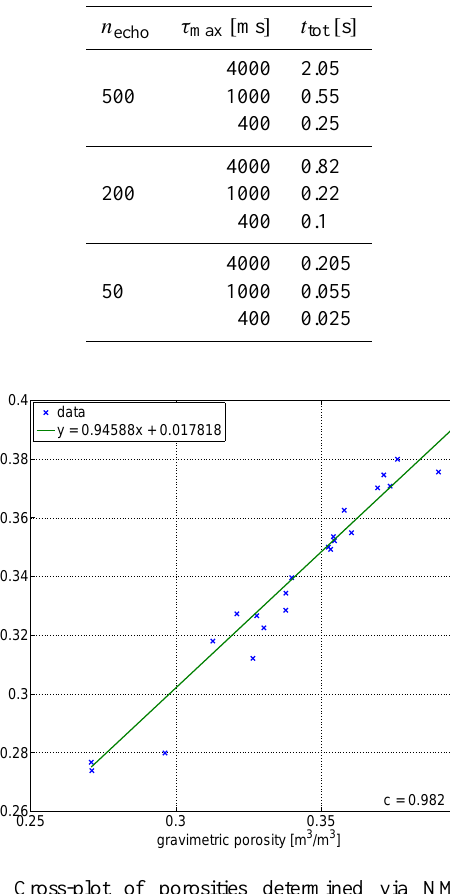
Table 2. Sequence parameter for the tested CPMG sequences. Start- ing from a fixed τ min =100µs, the echo spacing was increased up to τ max , which equals to the total acquisition time t tot given in column 3.